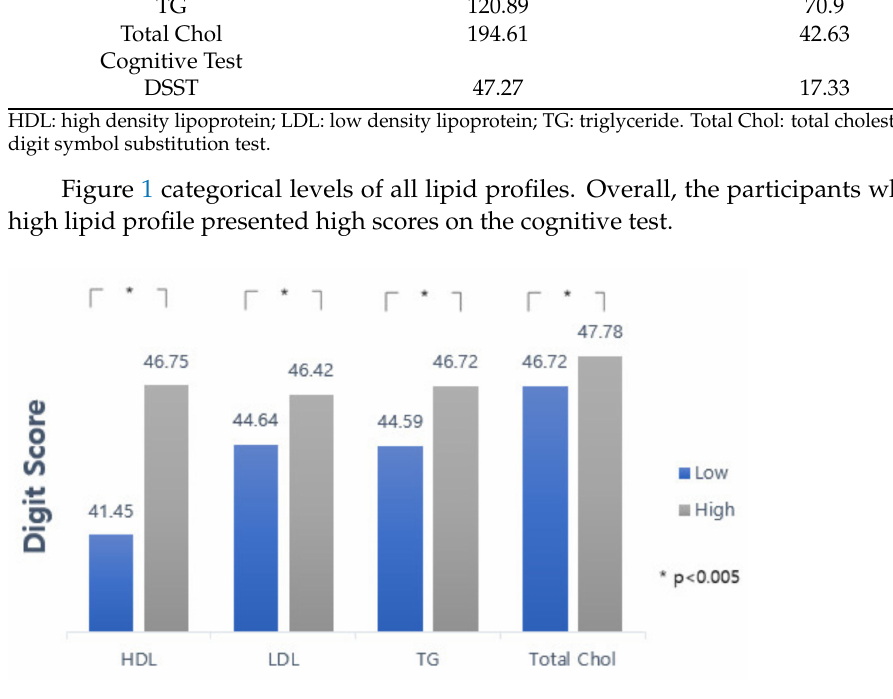
Figure 1. Comparison of the mean ( ± SD) cognitive test score (Digit Score) according to the abnormal baseline of different lipid profiles. Upper bar connecting to each side of the graph represents a significant difference using p